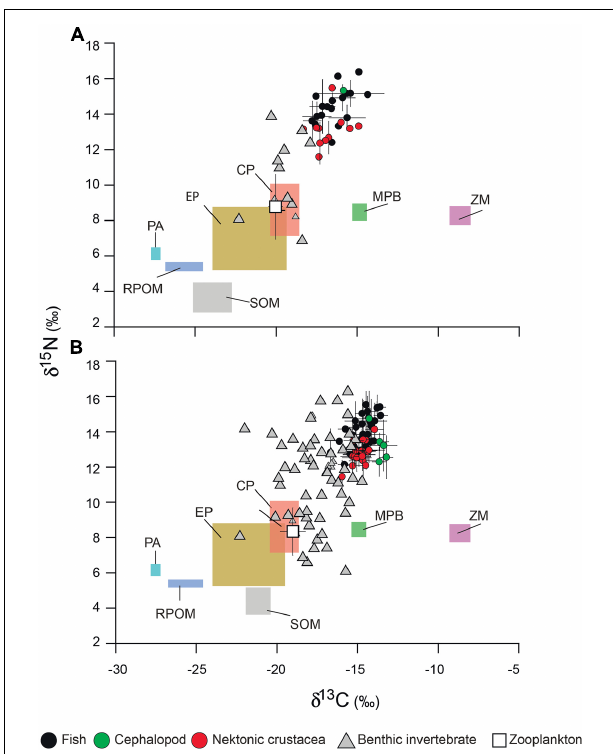
) of primary organic matter FIGURE 3 | Biplots of δ 13 C and δ 15 N values ( sources (color boxes) and consumers from (A) estuarine channel and (B) (cid:104) coastal sites of Gwangyang Bay. When n > 1, data are shown as the mean ± 1 standard deviation. Abbreviations: EP, estuarine phytoplankton; CP, coastal phytoplankton; MPB, microphytobenthos; SOM, sedimentary organic matter; RPOM, riverine particulate organic matter; PA, Phragmites australis ; and ZM, Zostera marina